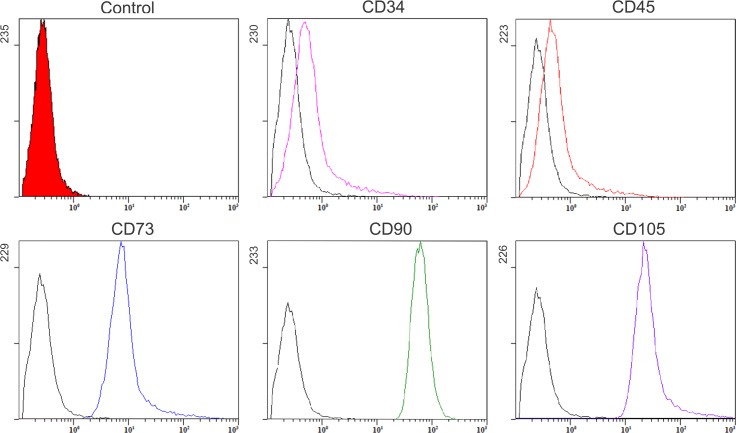
Identification of ADSCs (positive markers: CD73, CD90 and CD105; negative marker: CD34 and CD45) by flow cytometry analysis.